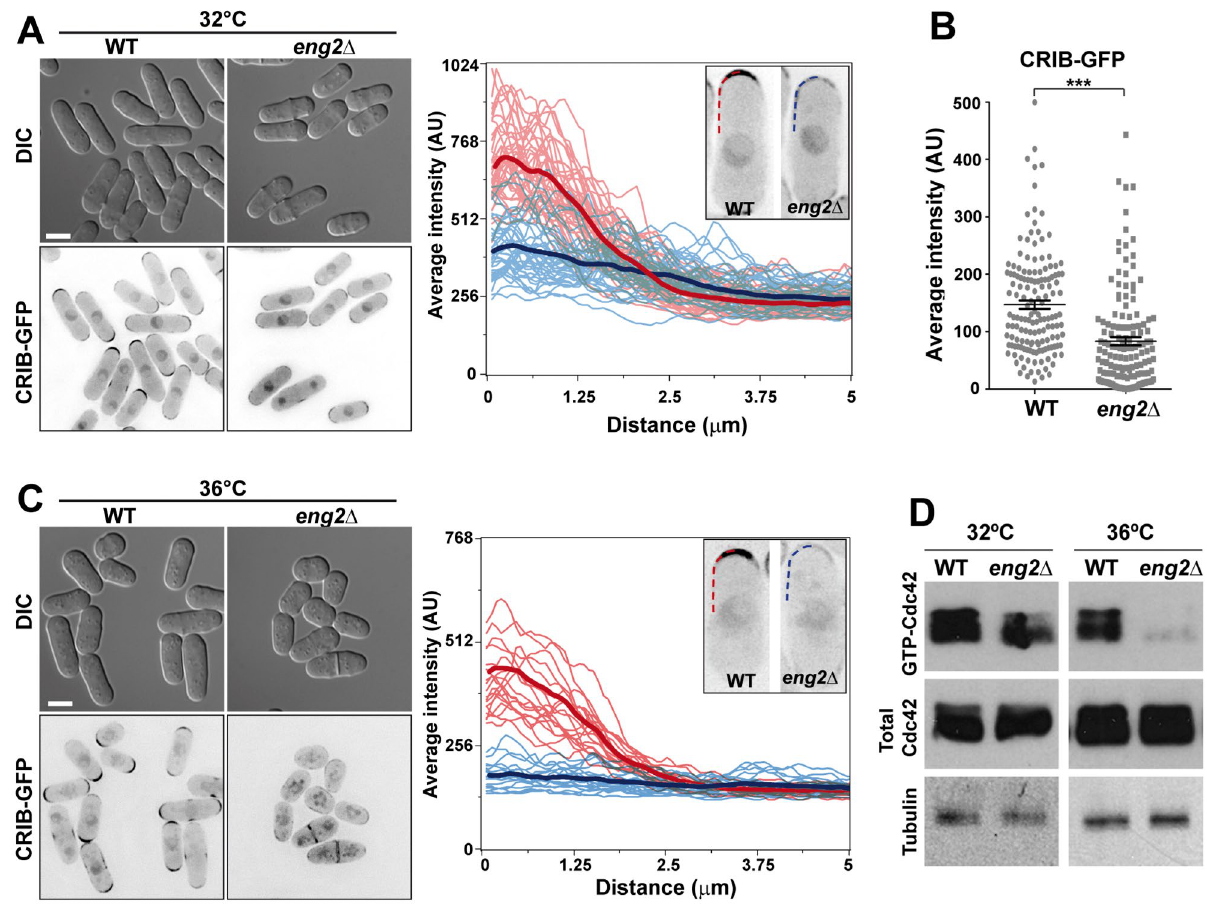
Figure 2. Eng2 regulates the levels of active Cdc42. (A) Localization of CRIB-GFP in wild-type and eng2 Δ cells grown in YES medium at 32 °C. Images show a single focal plane at the center of the cell (DIC) and the maximum intensity projection of 5 focal planes acquired at 0.3-µm intervals. Scale bar, 5 μm. The graph shows plots of the CRIB-GFP intensity along the membrane in wild-type (red) and eng2 Δ cells (blue). The thick line is the average of > 40 cell tips linescans for each strain. The images show a representative example of the majority of wild-type cells and eng2 Δ cells. Linescans were done on half tips, aligned at the cell center, as shown by the curved line in the image. (B) Average ± s.e.m. intensity of the CRIB-GFP signal at the tips of wild-type and eng2 Δ cells (n > 150 from 3 independent experiments. ***p-value < 0.0001). (C) Localization of CRIB-GFP in wild-type and eng2 Δ cells grown in YES medium at 36 °C for 10 h. Images show a single focal plane at the center of the cell (DIC) and the maximum projection of 5 focal planes acquired at 0.3-µm intervals. Scale bar, 5 μm. The graph shows plots of the average intensity along the membrane in wild-type (red) and eng2 Δ cells (blue). The thick line is the average of line scans from 20 cell tips. (D) GTP-Cdc42 levels in wild-type and eng2 Δ mutant cells. HA-cdc42 and HA-cdc42 eng2 Δ cells were grown at 32 °C and transferred at 32 °C or 36 °C for 3 h. Protein extracts were precipitated with GST-CRIB and blotted with anti-HA antibodies. Total HA-Cdc42 in cell extracts was visualized by western blot. Tubulin was used as loading